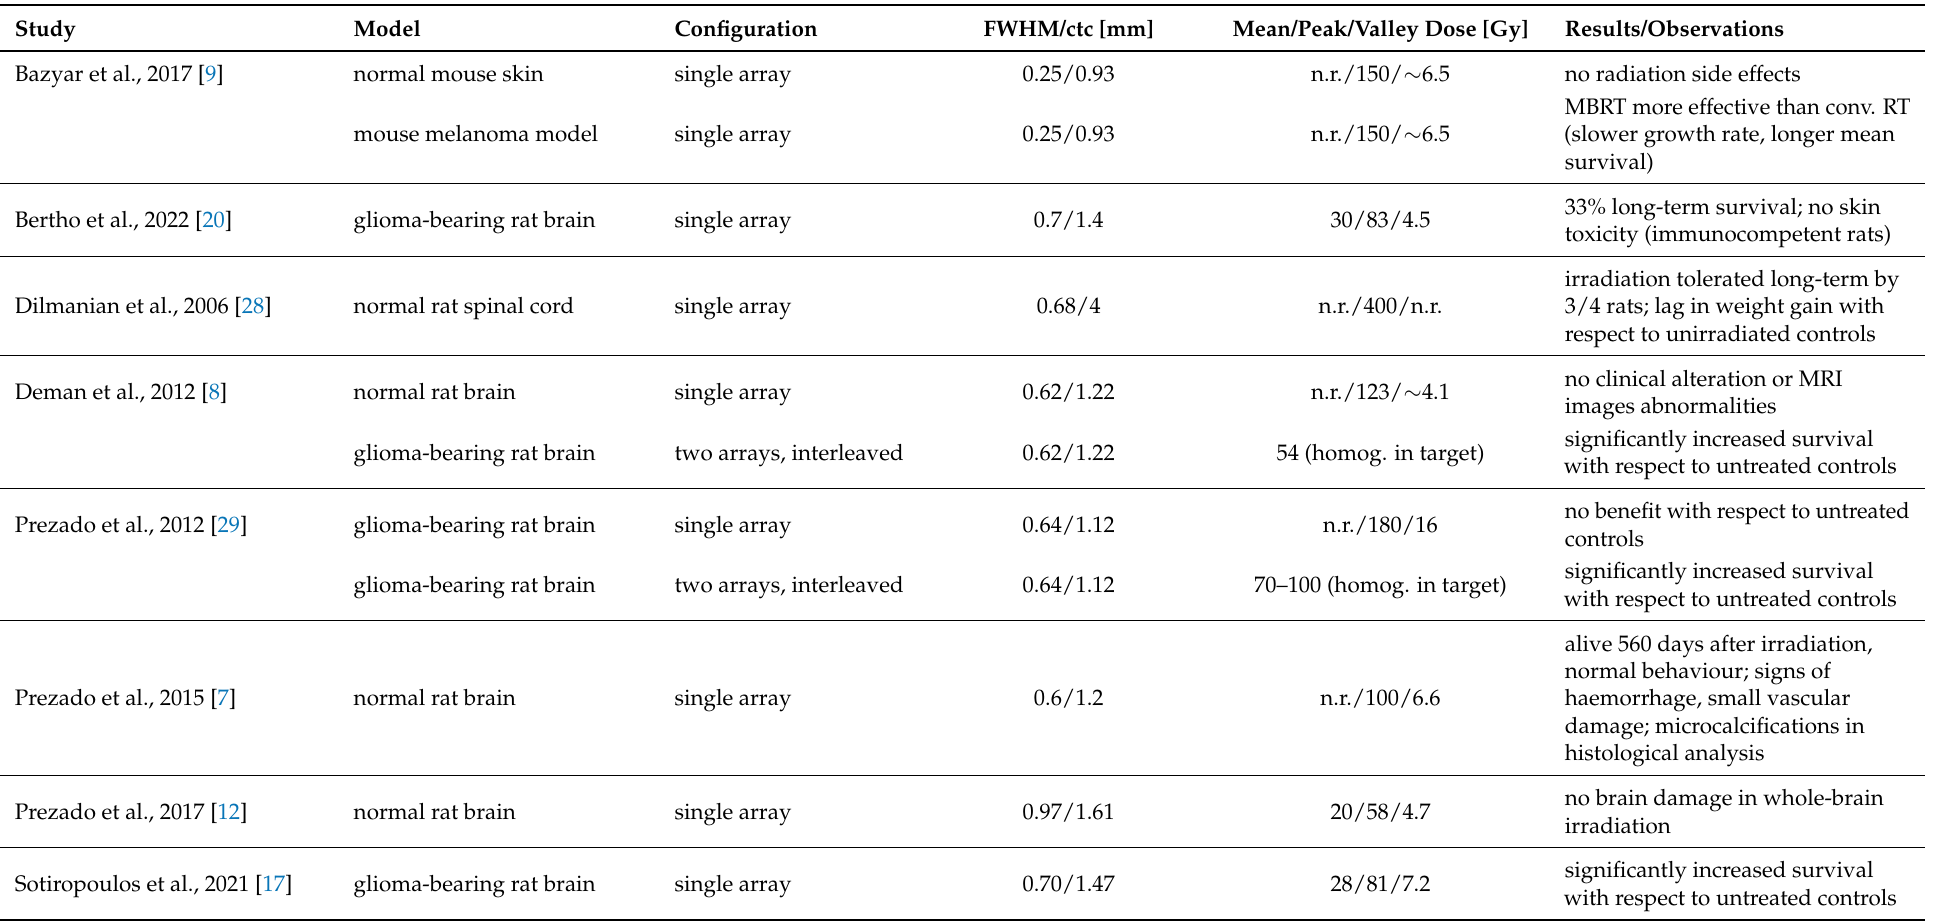
Table 6. Compilation of selected in vivo studies evaluating orthovoltage X-ray MBRT (n.r. = not